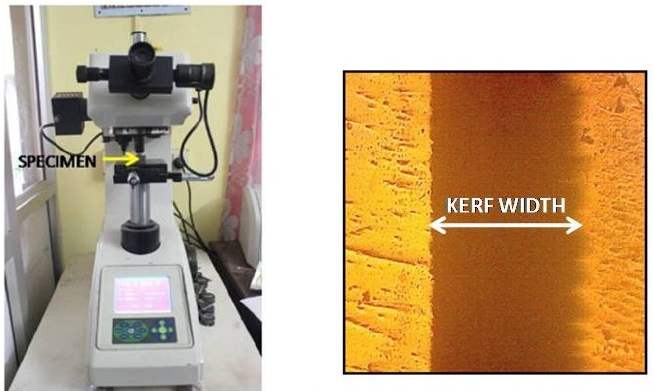
Figure 2. Measurement of K w of machined specimen using the microscope.